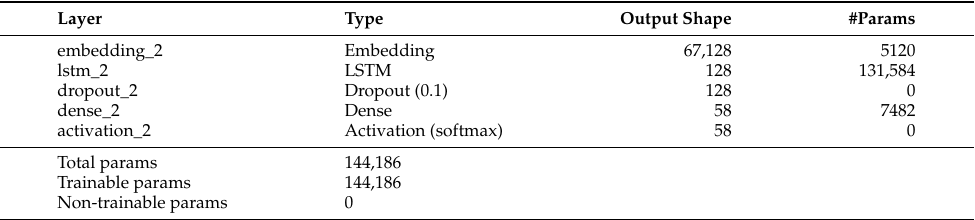
Table 8. Details of LSTM